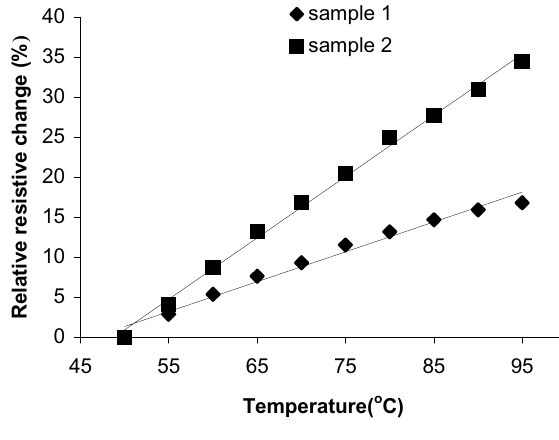
Figure 3. Variation in relative resistance ∆ R of the samples as a function of the increasing temperature